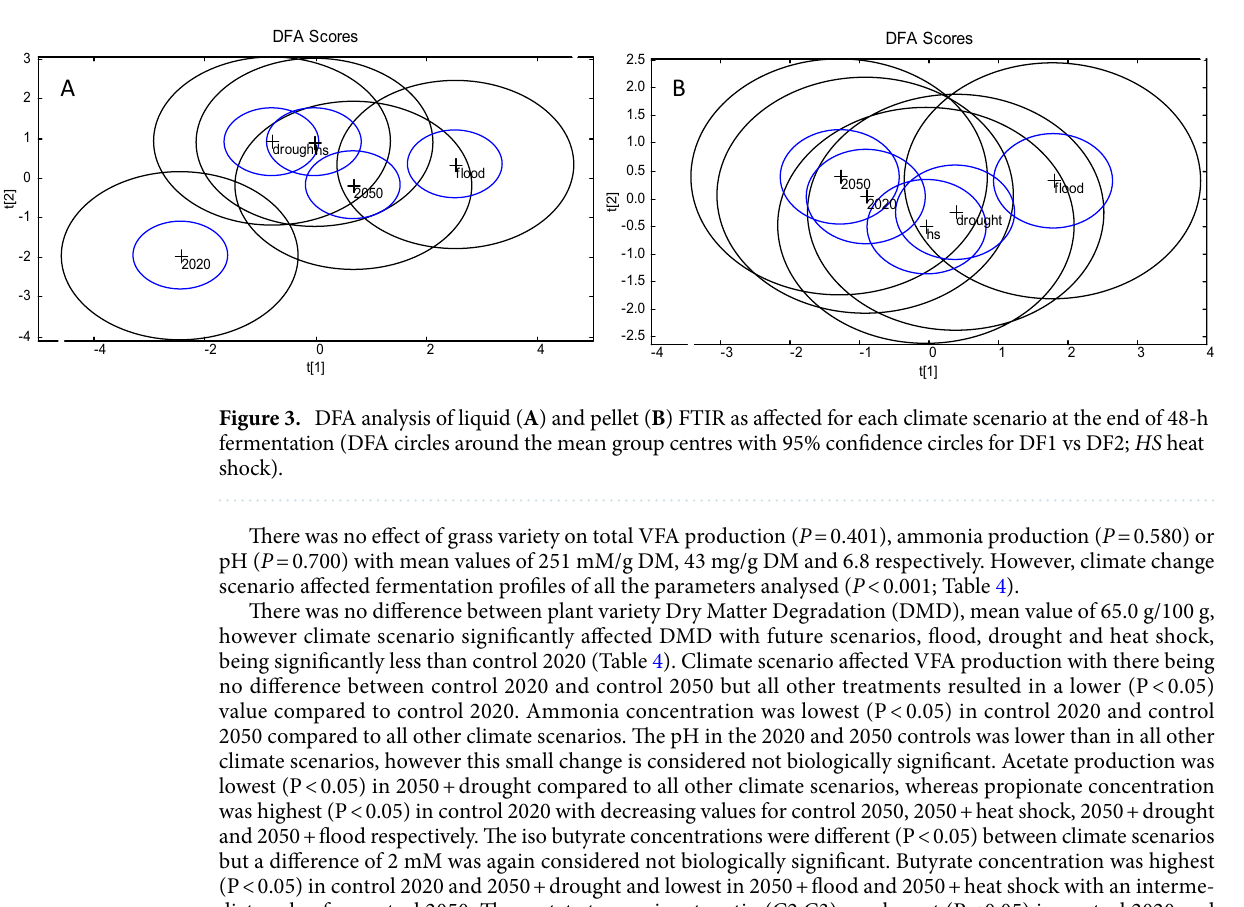
Figure 2. Effect of climate scenario on total gas production ( A ), total CO 2 production ( B ) and total methane production ( C ) at 48 h fermentation as affected by climate change scenario (all corrected for starting weight of dry matter); HS heat shock). Raw data points are overlaid on boxplots, coloured by replicate experiment. Notches represent 95% confidence intervals. Lower case letters indicate significant difference based on ls means with Tukey adjustment ( P < 0.05).